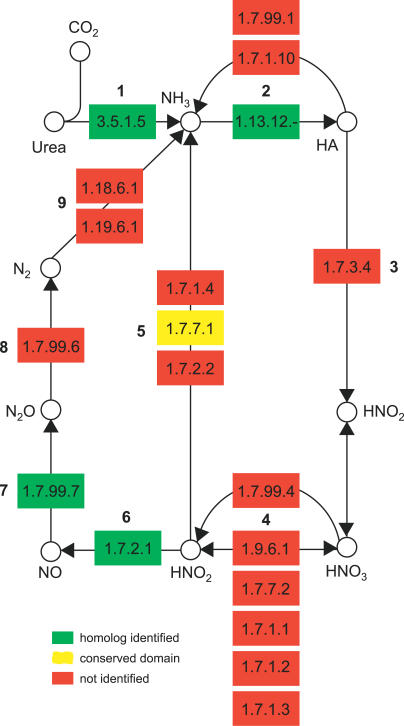
Ammonia Oxidation Pathway Components Identified in
C. symbiosum
Each step is mediated by the following enzymes: (1) urease, (2) ammonia monooxygenase, (3) hydroxylamine oxidoreductase, (4) nitrate reductase, (5) ferredoxin-nitrite reductase or formate-dependent nitrite reductase, (6) nitrite reductase, (7) nitric-oxide reductase, (8) nitrous-oxide reductase, and (9) nitrogenase.Box color indicates the identification status of genes encoding a particular step.NH
3, ammonia; HA, hydroxylamine; HNO
3, nitrate; HNO
2, nitrite; NO, nitric oxide; N
2O, nitrous oxide; N
2, dinitrogen. Diagrams are based on KEGG pathway maps and include enzyme classification numbers (EC) for each step in boxes when available. See
Table 3 for more information.